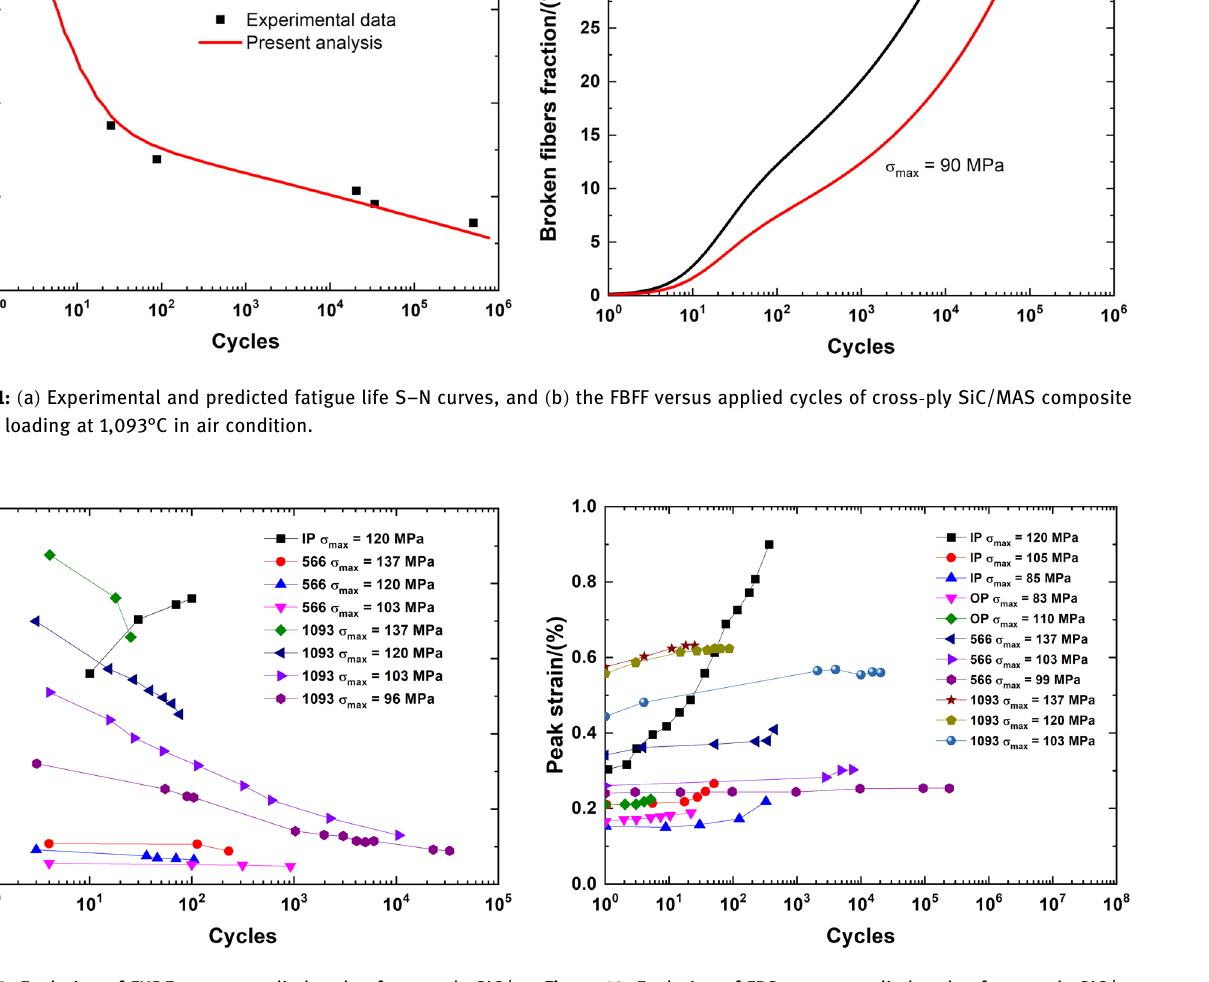
Figure 14: Evolution of FPS versus applied cycle of cross - ply SiC/ MAS composite under IP - and OP - TMF and IF